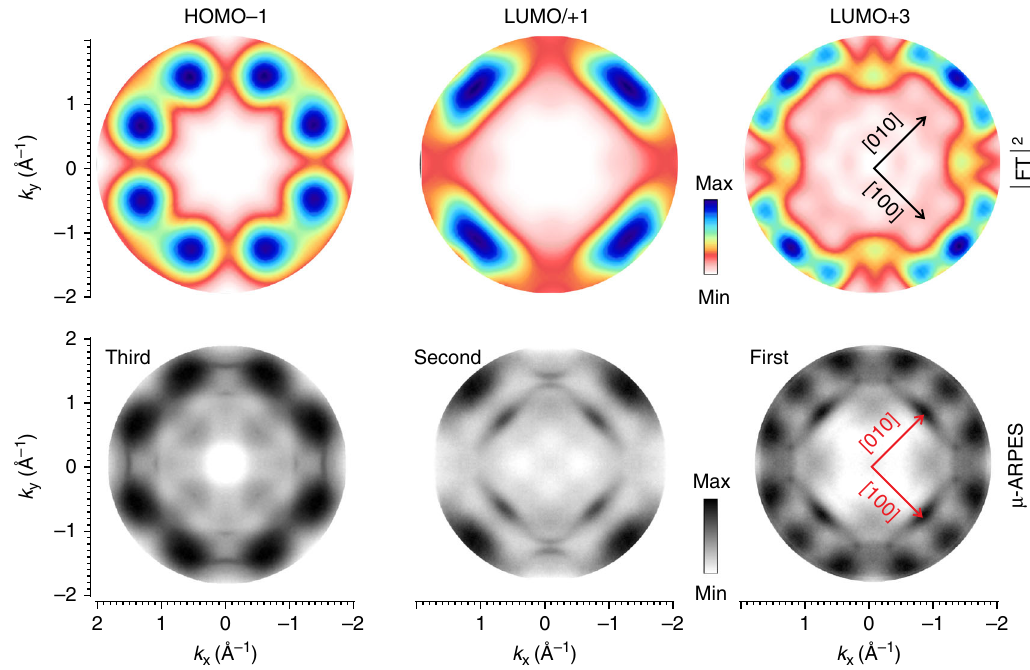
Fig. 5 Photoemission tomography. Comparison between μ -ARPES measured patterns ( bottom ) and the correspondent calculated | FT | 2 of the molecular orbitals ( top ). In the experimental maps, the sharp inner features are related to the sp band of the copper